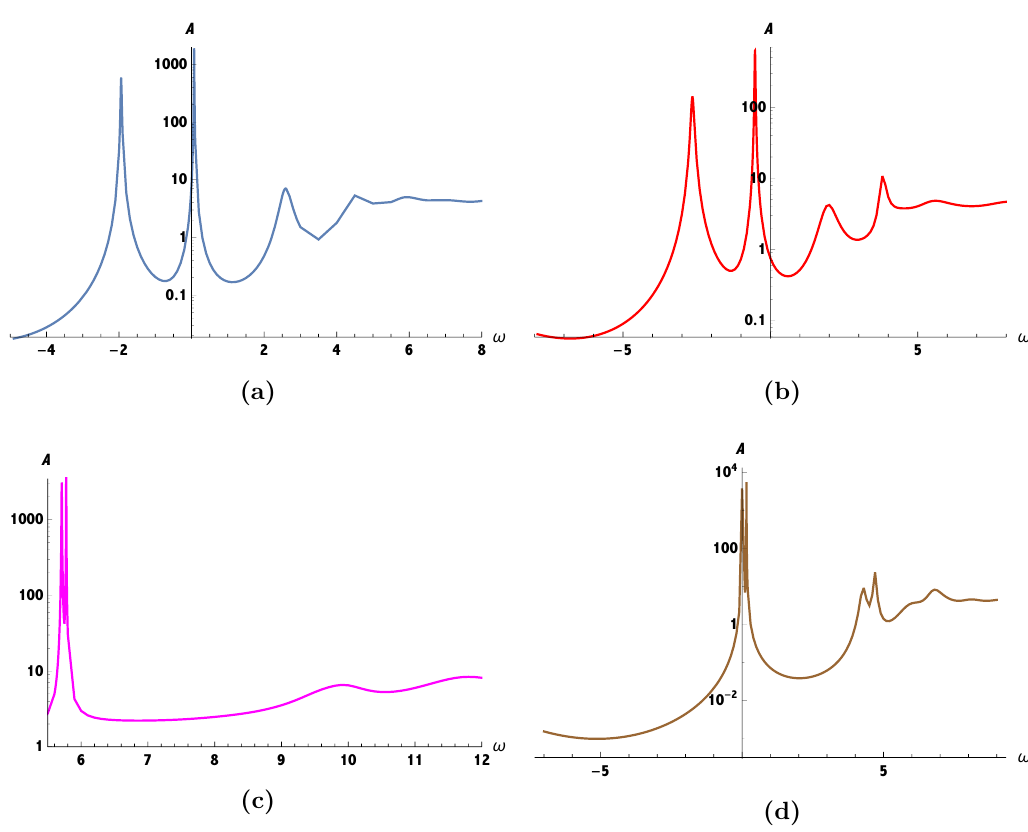
Figure 6. Plot of spectral function A vs. w with q = 9 in absence of ionic lattice; (a) k x = 9 . 8 , k y = 3 . 8 (blue), (b) k x = 9 . 8 , k y = 0 (red), (c) k x = 0 , k y = 0 (magenta), (d) k x = 8 . 43381 , k y = 6 . 287